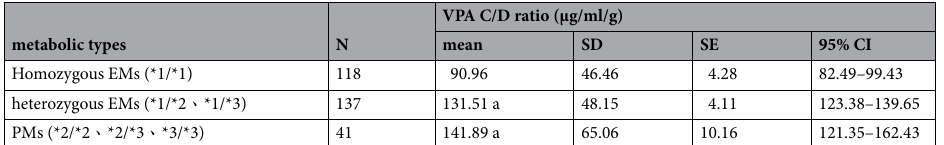
Table 3. Steady-state serum C/D Ratio of VPA between CYP2C19 metabolic types. a p < 0.01 compared with Homozygous Ems; power (1 – β) = 0.8486 at type I level of 0.05. EMs: extensive metabolizers; PMs: poor metabolizers; *1/*1: 681GG, 636GG; *1/*2: 681GA, 636GG; *1/*3: 681GG, 636GA; *2/*2: 681AA,